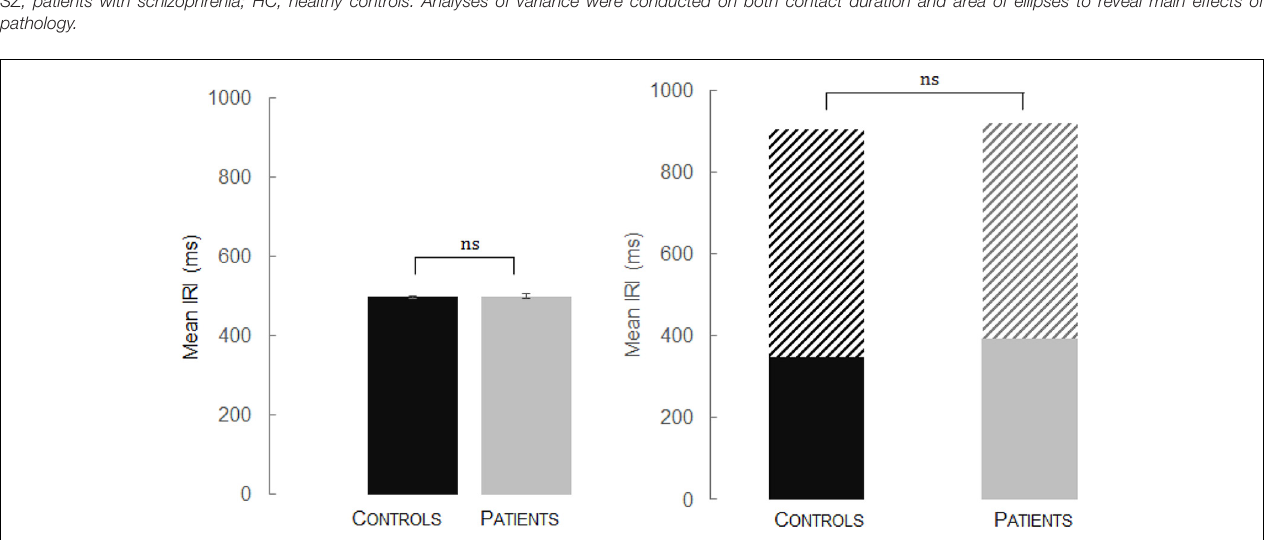
A one-way ANOVA conducted on the coefficients of